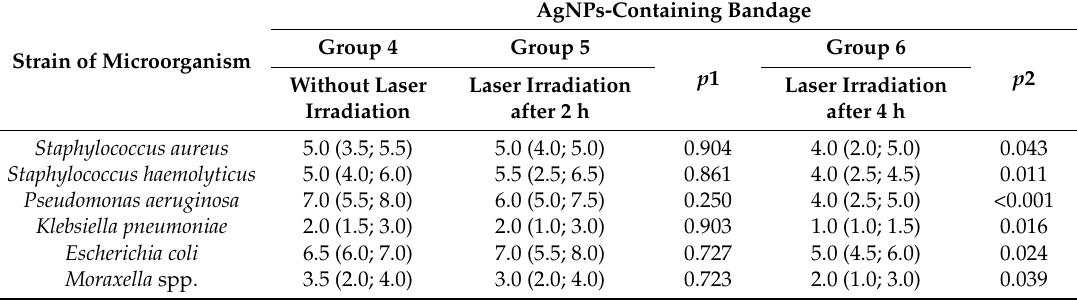
Table 6. The number of CFU of the investigated microorganisms along the edge of the medical gauze bandage containing AgNPs, (Me (Q 1 ; Q 3 )) and p —the level of statistical significance between the